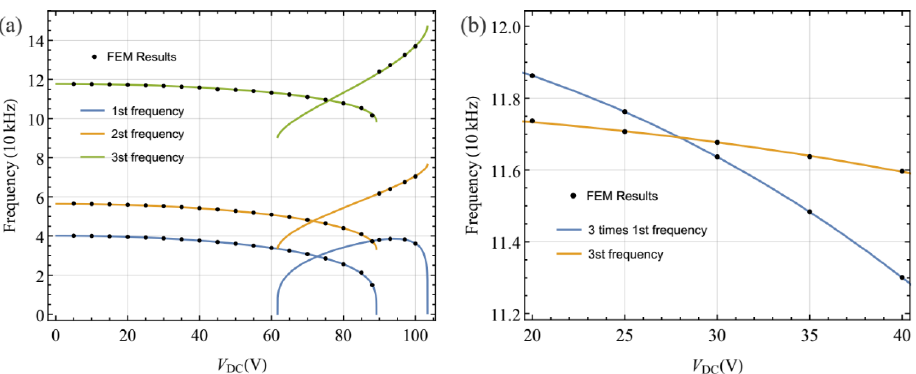
Figure 3. ( a ) Variation of the first three natural frequencies with DC voltage; ( b ) variations of three times the first natural frequency and the third natural frequency with DC voltage. Legend: FEM, finite element method.